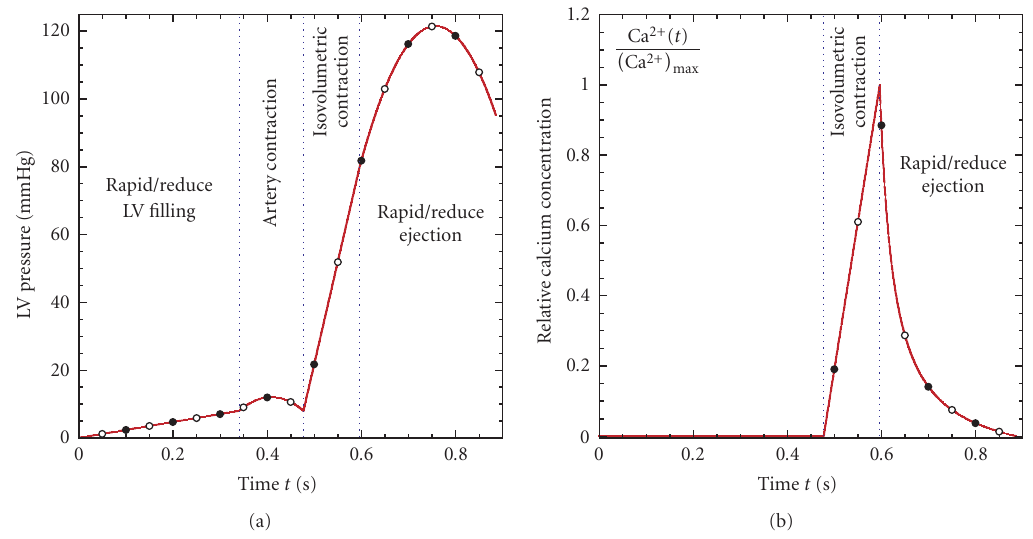
Figure 4: (a) A model blood pressure profile P ( t ) in the left ventricle, in mmHg. The dots represent time steps when displacement U m is measured. Solid dots: time t = 0 . 1,0 . 2, ... ,0 . 8 second; open dots: t = 0 . 05,0 . 15, ... ,0 . 85 second. (b) A model relative calcium kinetics curve Ca 2+ ( t ) / (Ca 2+ ) max in the left ventricular wall.